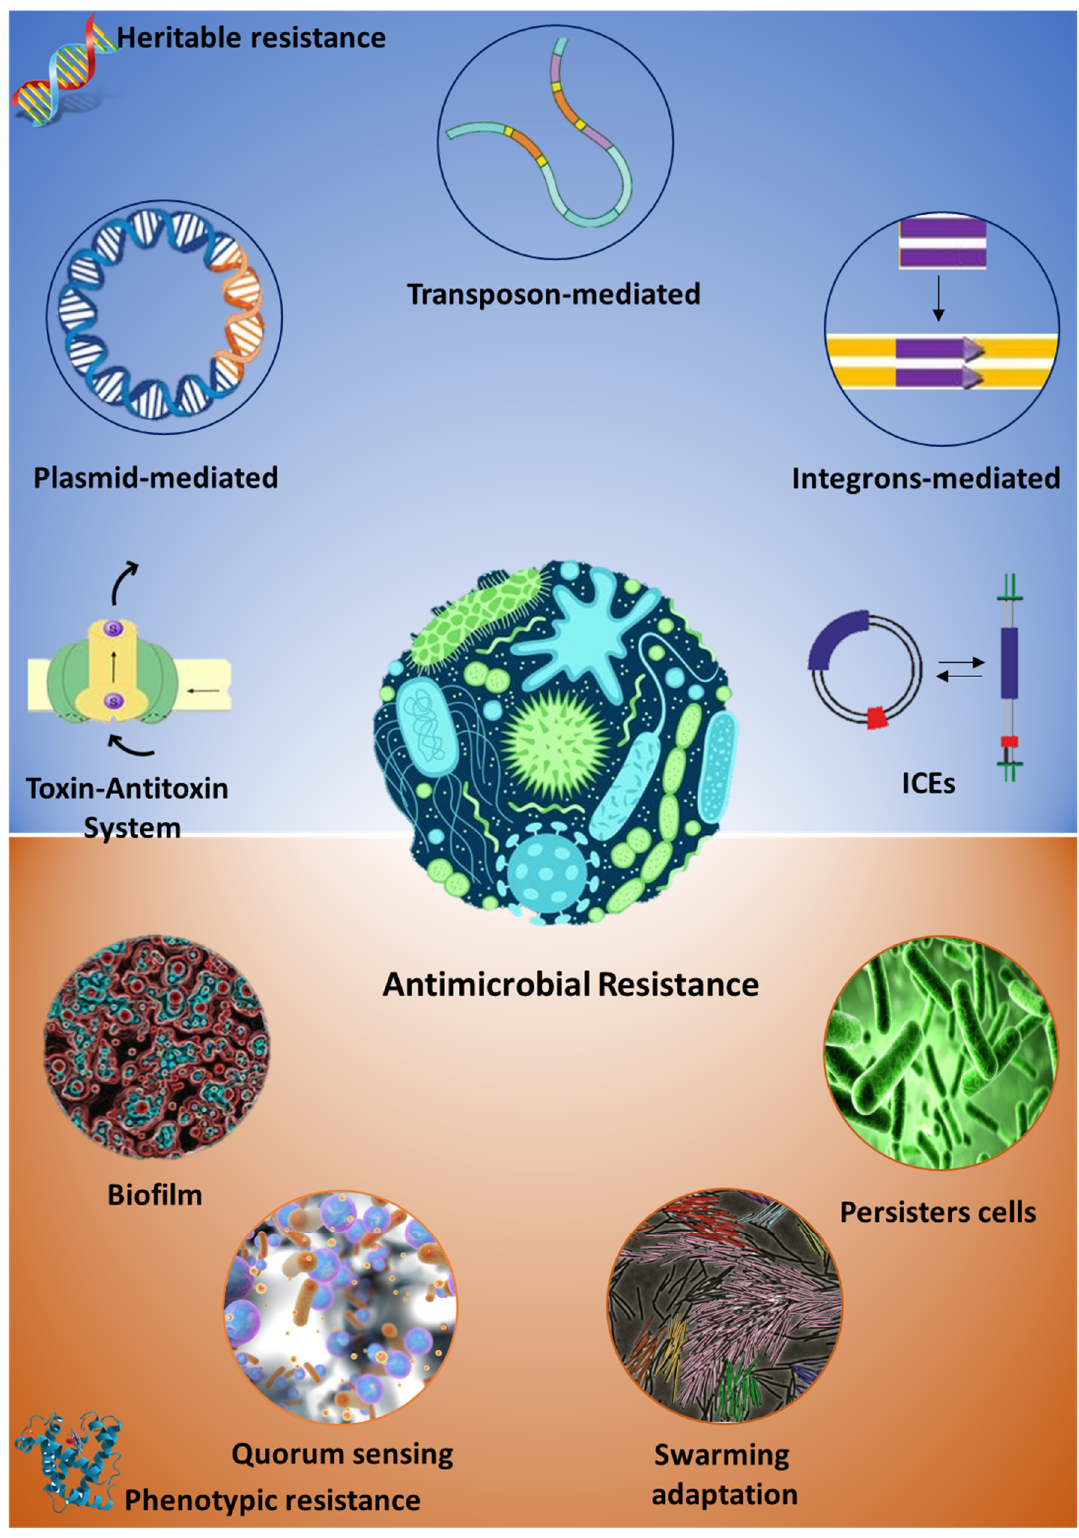
Figure 1. Molecular mechanisms driving antimicrobial resistance. Image depicts heritable (blue framed) and phenotypic (orange framed) mechanisms of antimicrobial resistance in bacteria. ICES = Integrative and Conjugative Elements.